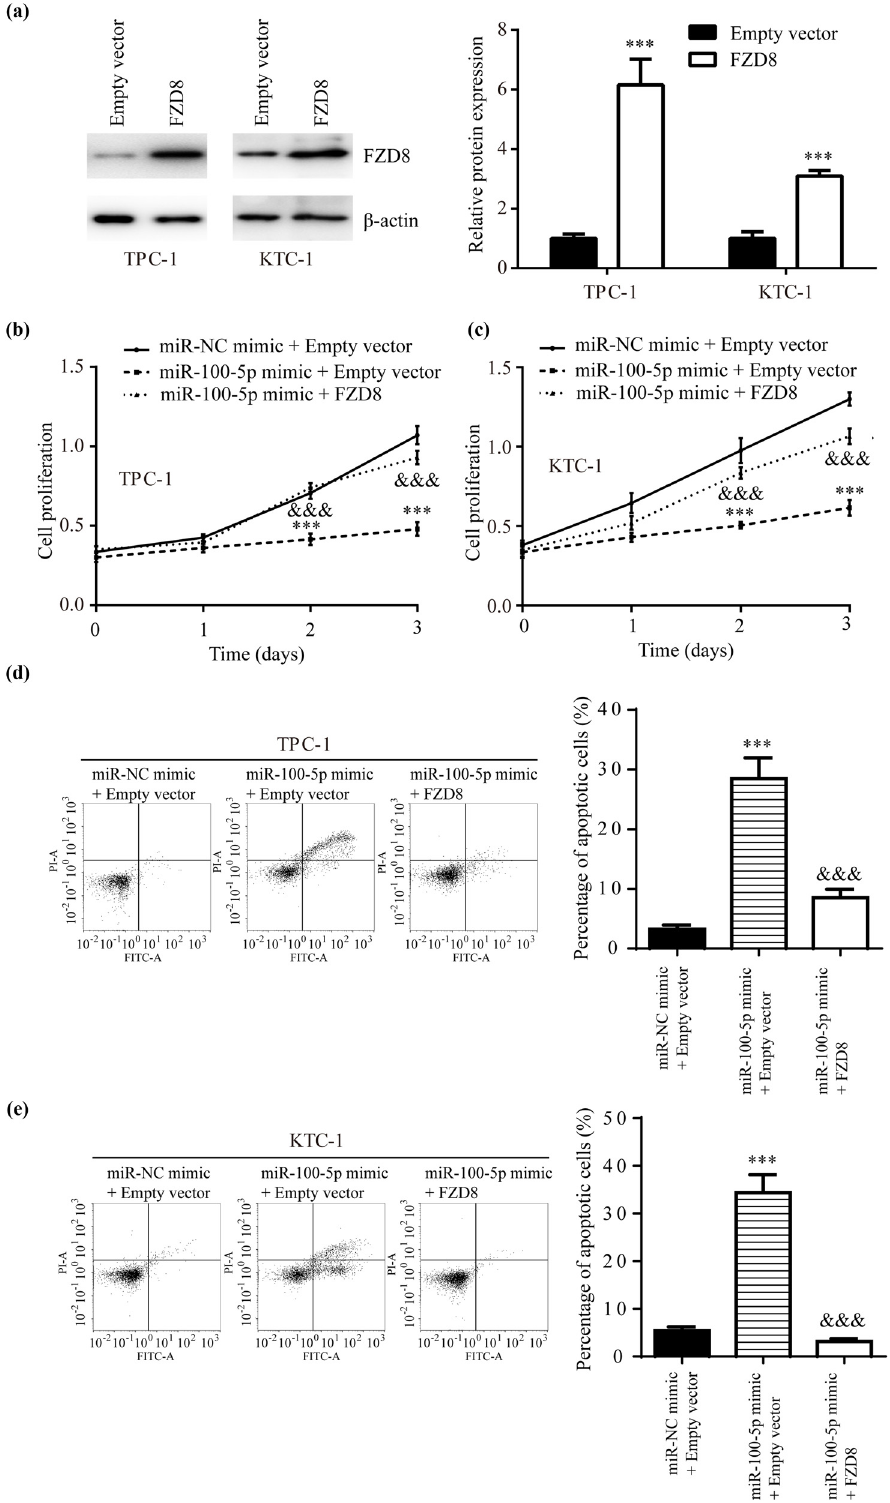
Figure 4: miR - 100 - 5p/FZD8 regulated PTC cell proliferation and apoptosis: ( a ) western blotting showed that transfection of full length FZD8 increased FZD8 protein expression in TPC - 1 and KTC - 1, ( b and c ) the CCK8 assay revealed that miR - 100 - 5p mimic inhibited cell proliferation, this e ff ect was attenuated by FZD8 in TPC - 1 and KTC - 1, and ( d and e ) fl ow cytometry analysis presented that miR - 100 - 5p mimic promoted cell apoptosis and this e ff ect was attenuated by FZD8 in TPC - 1 and KTC - 1. ***, vs miR - NC mimic + Empty vector, p < 0.001; &&&, vs miR - 100 - 5p mimic + Empty vector, p <